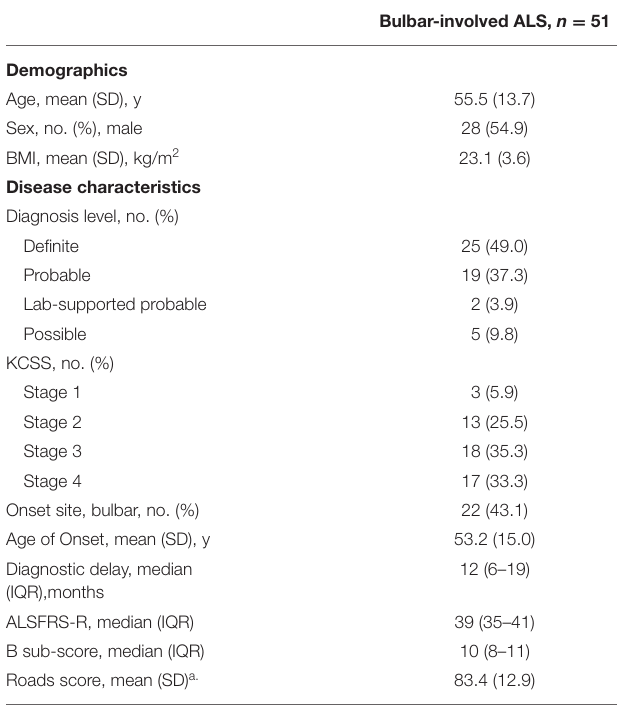
TABLE 1 | Baseline characteristics of the patients examined in our study. Bulbar-involved ALS, n = 51